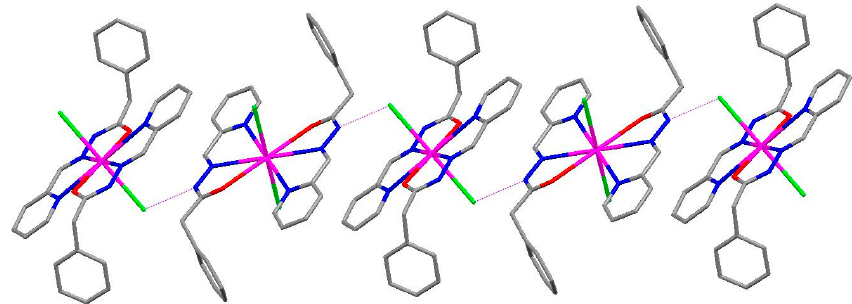
Figure 2. 1D chained structure by the hydrogen bonds.